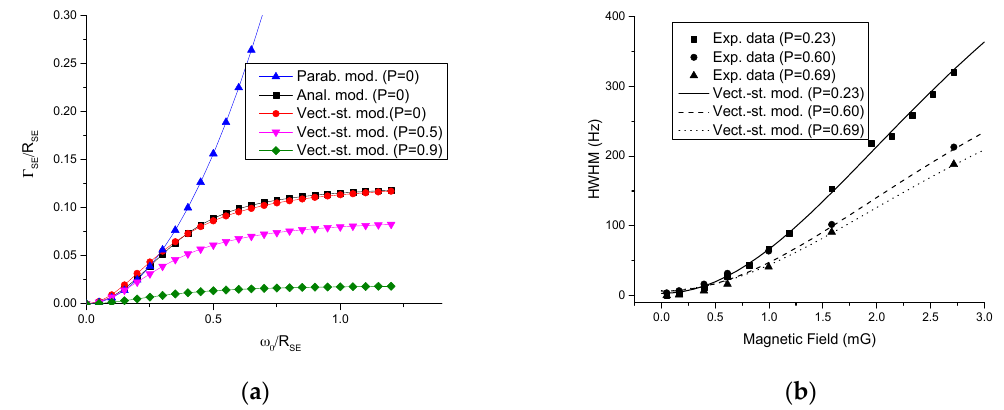
Figure 3. ( a ) The frequency profile of the width (spin-exchange part only, Γ SE ) using the prediction of the derived here vector-statistical model Equation (6) ( P = 0, 0.5, 0.9) and analytical expression for P = 0 [26], which at small bias field can be approximated with a parabola [15]; ( b ) Comparison of a vector-statistical model and well controlled experimental measurements [25] for magnetic resonance width (this includes spin destruction contributions, Equation (7)) as the function of the bias field for different polarizations. Excellent agreement can be observed between the vector-statistical model and the experimental data. This model also reproduces results for the case of a large magnetic field and a high polarization: 2 π Γ SE = R SE ( 1 − P ) /5 derived for the radio-frequency (RF) magnetometer and used for finding the optimal pumping rate when the pumping rate term is added: Γ = R SE R SD 5 R